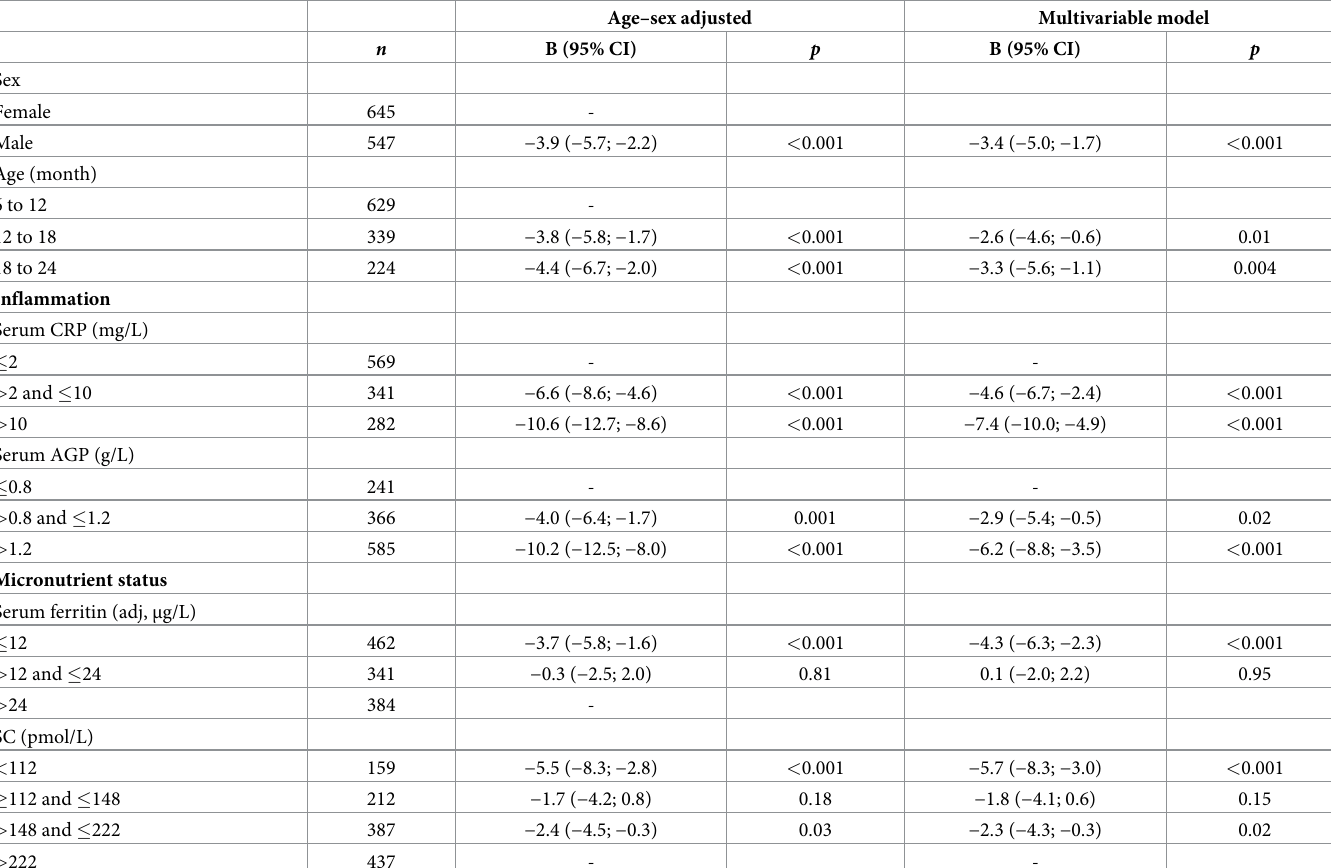
Table 4. SC and other correlates of baseline hemoglobin (g/L) in 1,192 children with MAM 1 .